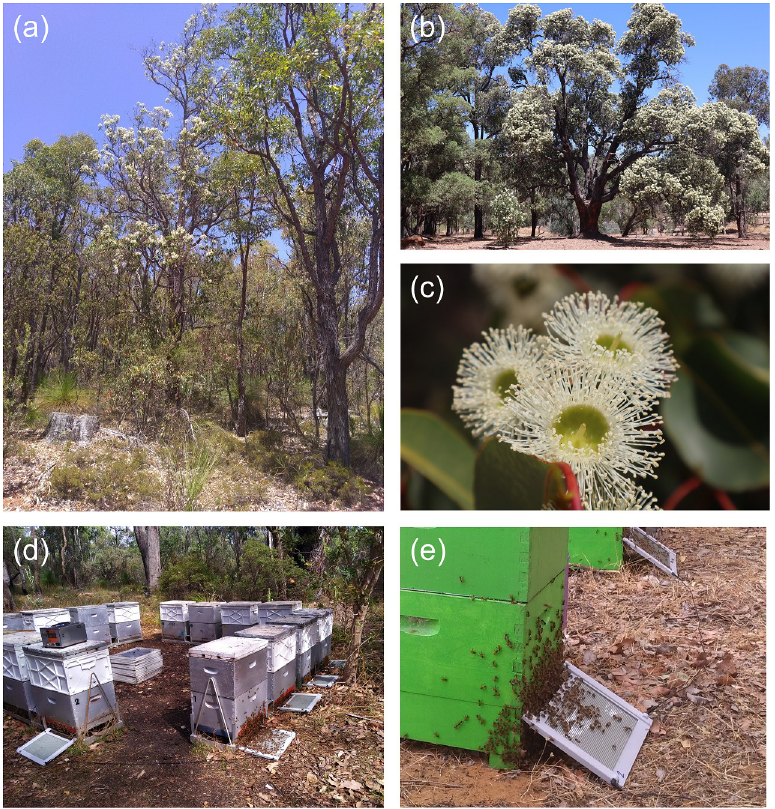
Fig 2. Bee venom sampling during the flowering of Corymbia calophylla (marri). (a) Marri woodland ecosystem. (b) C . calophylla in peak flower, (c) C . calophylla in flower. (d-e) bee venom harvest using stimulating glass plates at the front of the